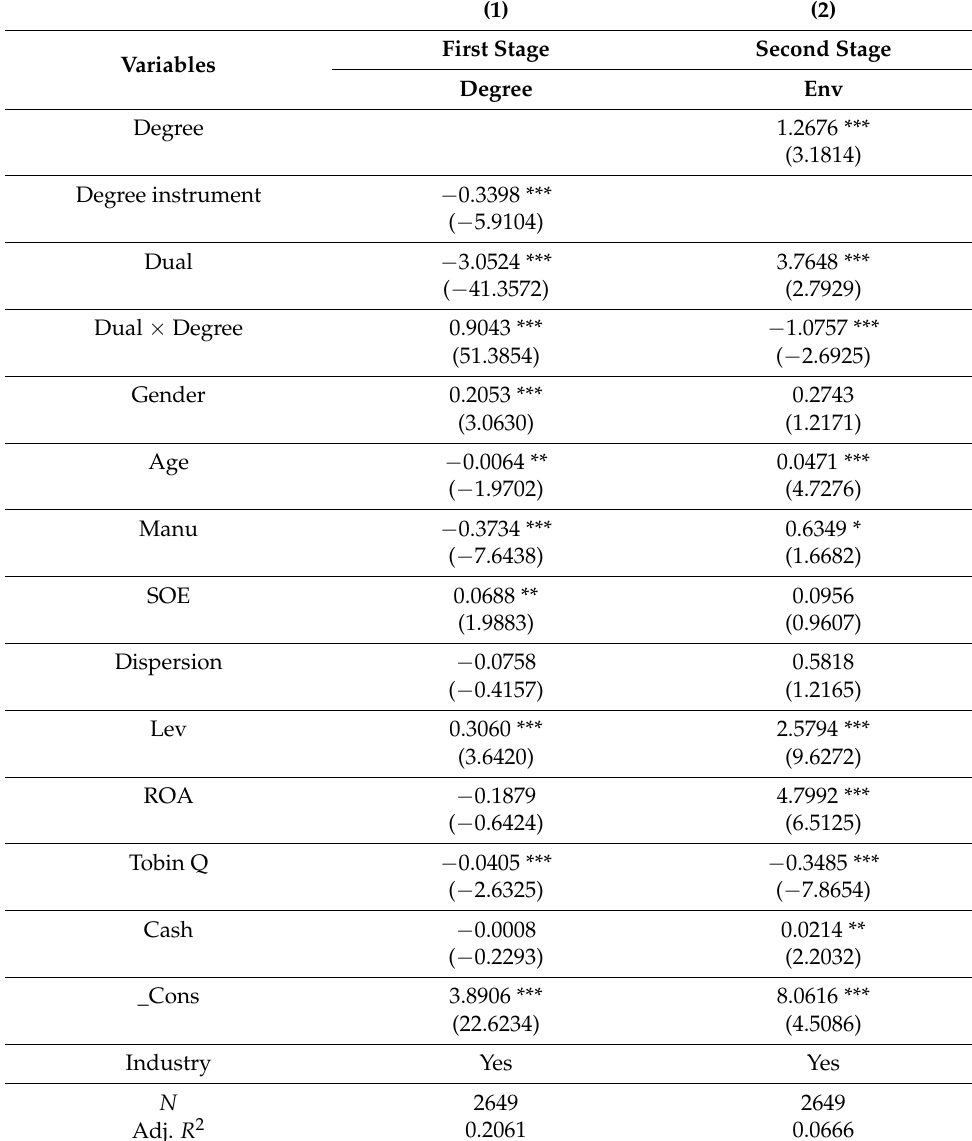
Table 5. Regression of instrumental variables (2SLS).